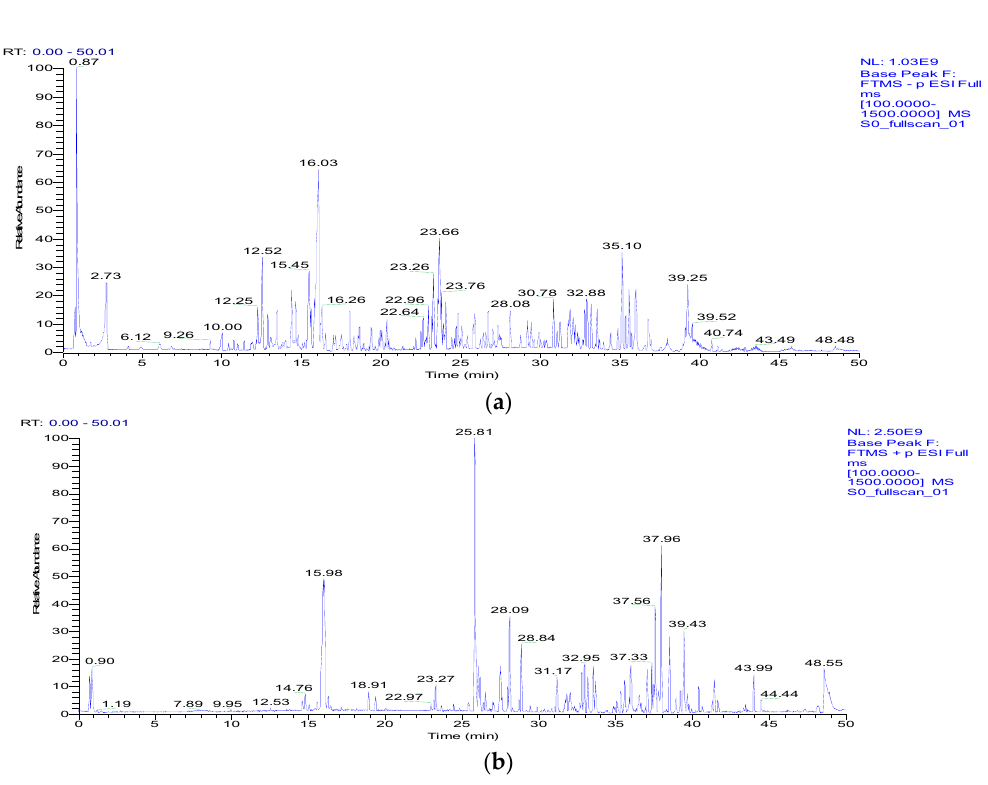
Figure 1. Base peak chromatogram of Melastoma dodecandrum Lour. in negative ion mode ( a ) and positive ion mode ( b ) using UPLC-ESI-Q-Exactive Focus-MS/MS.